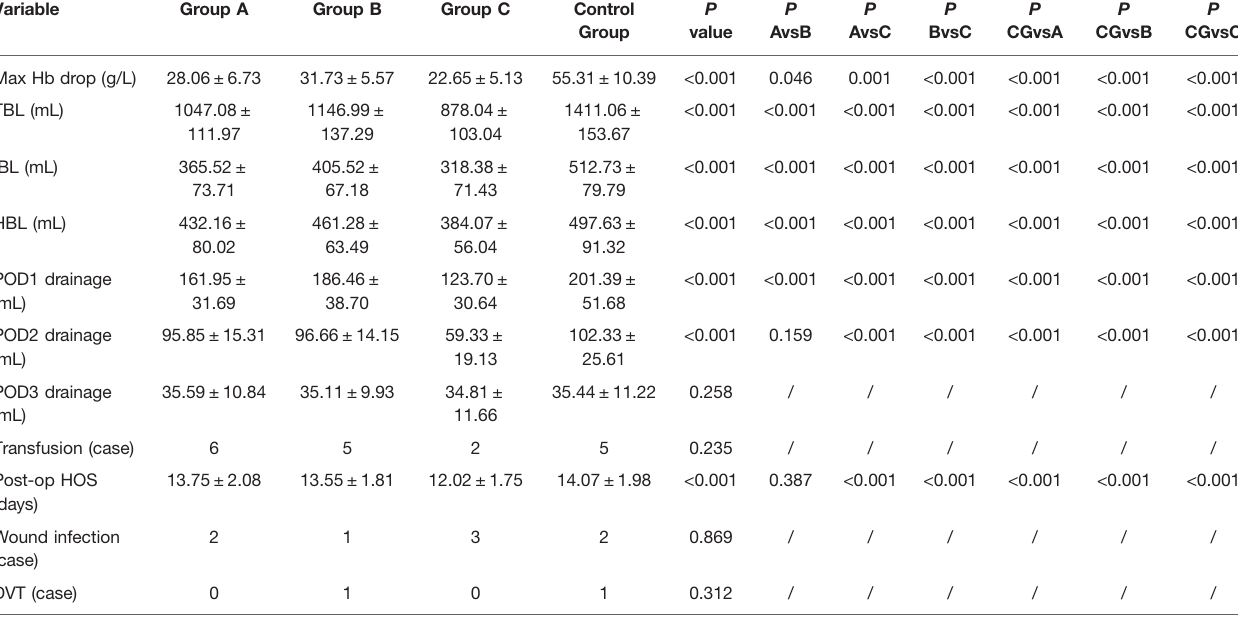
TABLE 2 | Postoperative outcome among the 4 groups. Variable